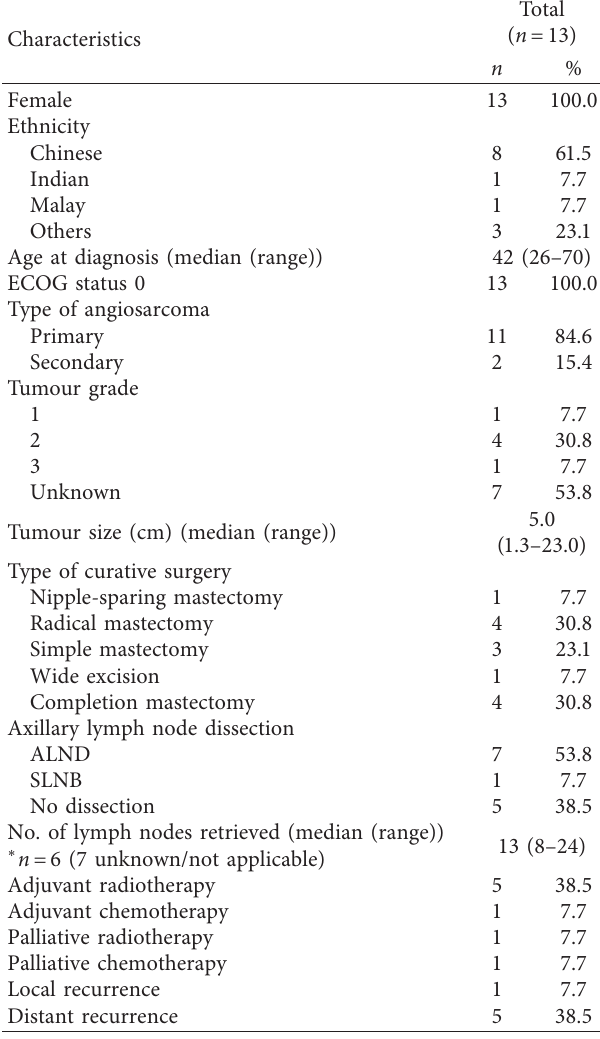
Table 1: Summary of patient